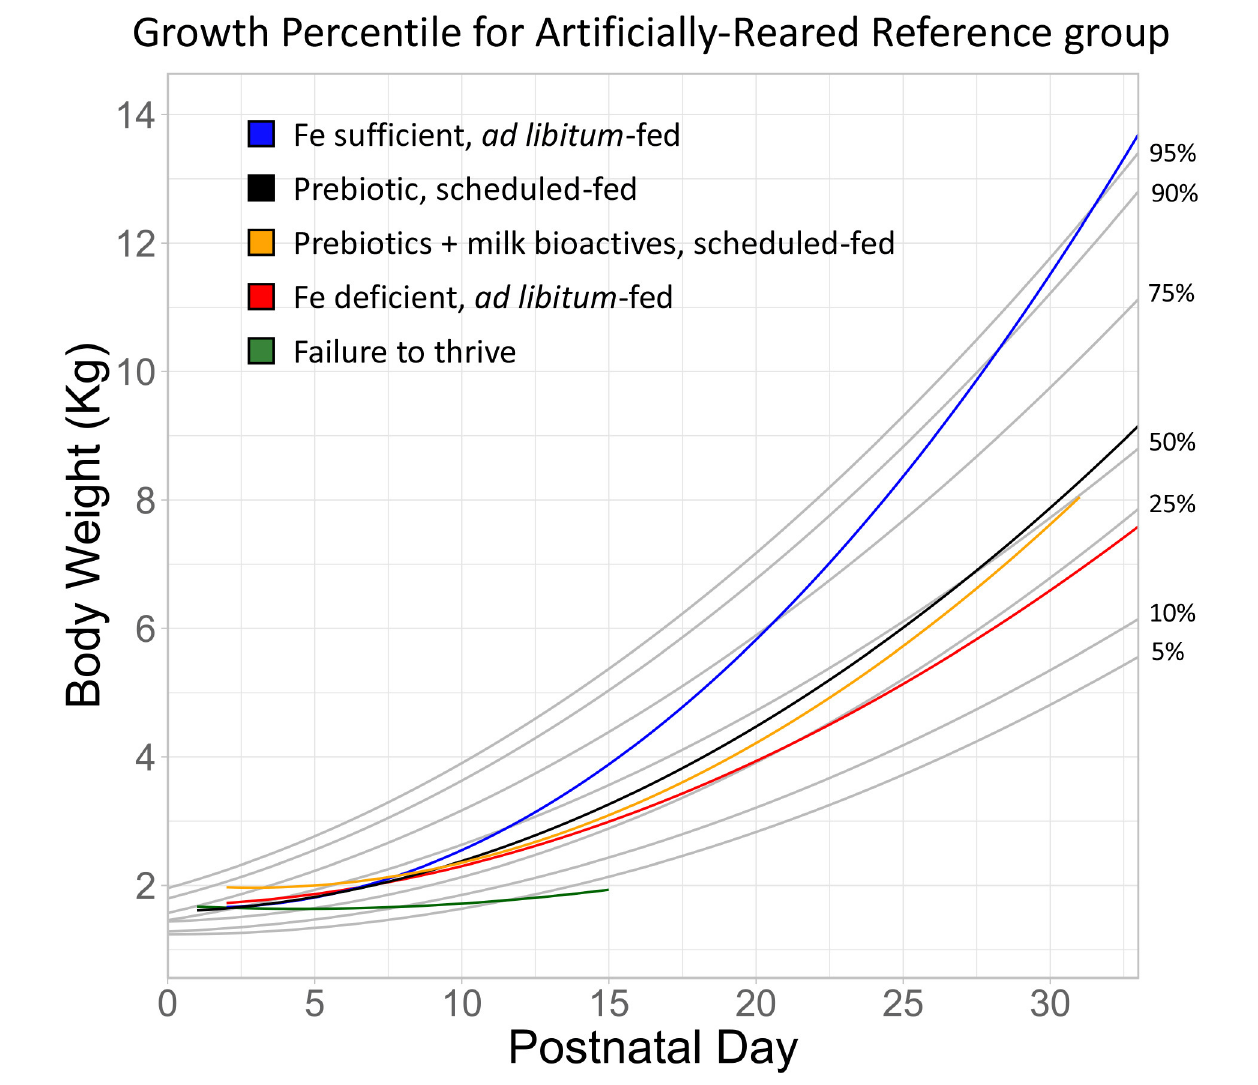
FIGURE 3 | Growth of artifically-reared pigs from representative experimental groups overlayed onto growth curves developed from the Artificially Reared Reference group animals. The blue and red lines represent ad libitum -fed pigs on an iron sufficient or deficient diet (20). The black line represents scheduled-fed pigs supplemented with a prebiotic combination (polydextrose and galactooligosaccharide) (16). The yellow line represents scheduled defined-fed pigs supplemented with prebiotics and milk bioactives (17). Lastly, the green line represents pigs that exhibited failure to thrive. The body weight of these pigs did not increase within two weeks of study enrollment, resulting in humane euthanasia. All together, the plotted cases represent accelerated growth (blue), typical growth (black and yellow), reduced growth (red), and failure to thrive